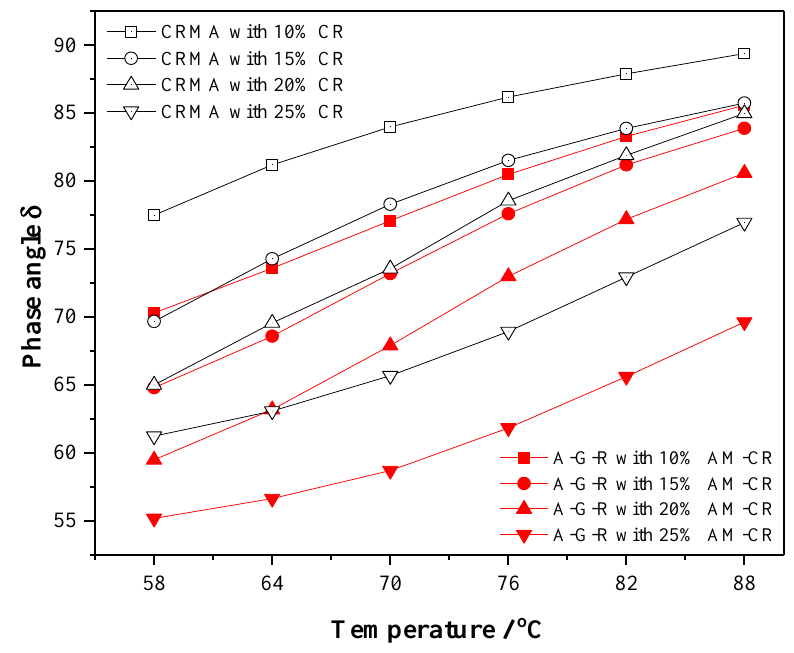
Figure 7. The phase angle ( δ ) of CRMA and A–G–R.